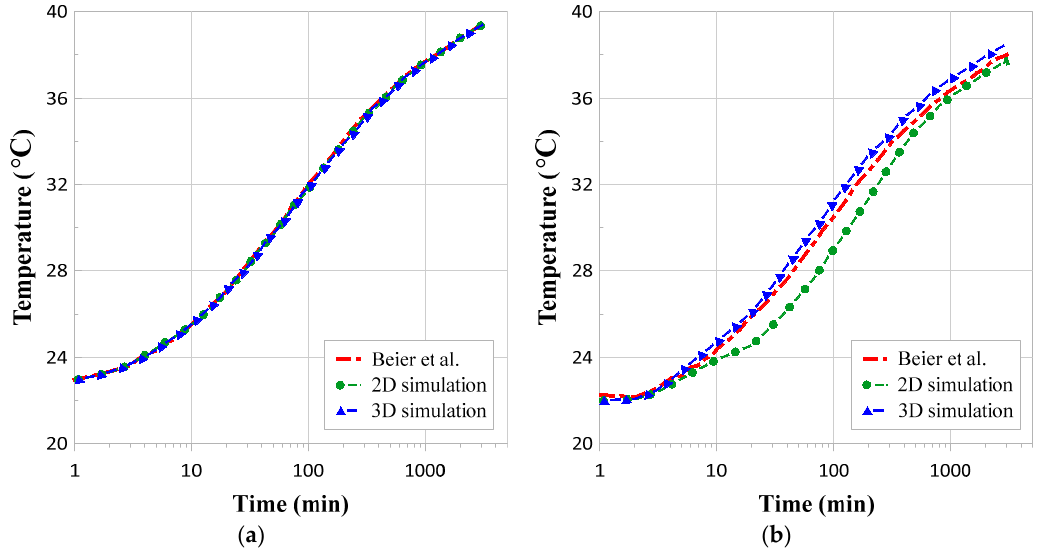
Figure 4. Temperature changes from 2D and 3D simulation results vs. temperature changes of experimental data of Beier et al. [32]: ( a ) inlet; ( b ) outlet temperature.